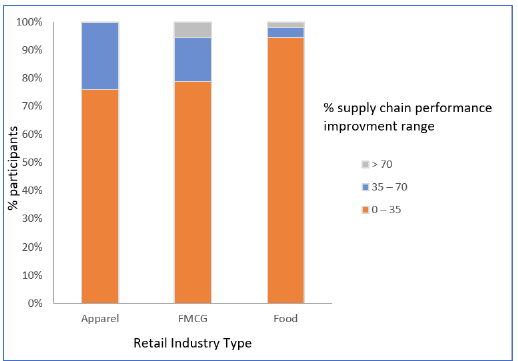
Figure 4. Percentage distribution of category I respondents by retail industry type.